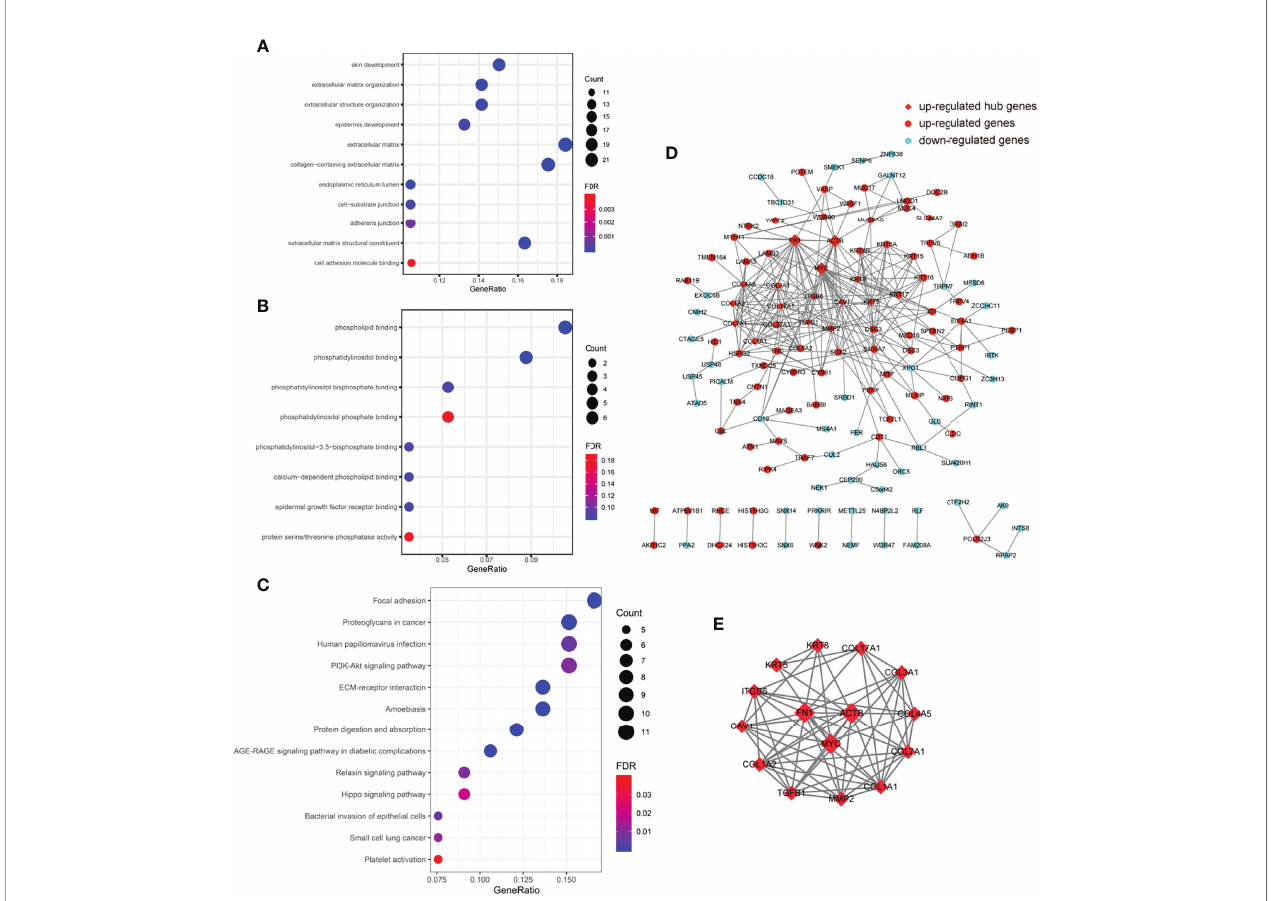
FIGURE 4 | Functional enrichment and gene co-expression network analysis. (A) Top 12 signi fi cantly enriched GO terms (FDR < 0.001, count >10) ranked by gene ratio in BP (top 4 items), CC (middle 5 items), and MF (bottom 2 items) of 143 upregulated genes in platelets of the ESCC group compared to the control group. (B) Enriched GO terms (FDR < 0.2) of 80 downregulated genes in platelets of the ESCC group compared to the control group. All the enriched GO terms belonged to MF. (C) Enriched KEGG terms (FDR < 0.05) of 143 upregulated genes in platelets of the ESCC group compared to the control group. (D) Two hundred and twenty-three DEGs imported to String to generate a gene co-expression network containing 132 nodes and 281 wedges. Red-colored dots indicated 85 upregulated genes and blue-colored dots indicated 47 downregulated genes. Red square indicated hub genes ( FN1 , ACTB , and MYC ) with highest values of degree. (E) Top 15 hub genes ranked by degree (>12) in Cystoscope were highly clustered and centered among FN1 , ACTB , and MYC . BP, biological process; CC, cellular component; DEGs, differentially expressed genes; ESCC, esophageal squamous cell carcinoma; FDR, false discovery rate; GO, Gene Ontology; KEGG, Kyoto Encyclopedia of Genes and Genomes; MF, molecular